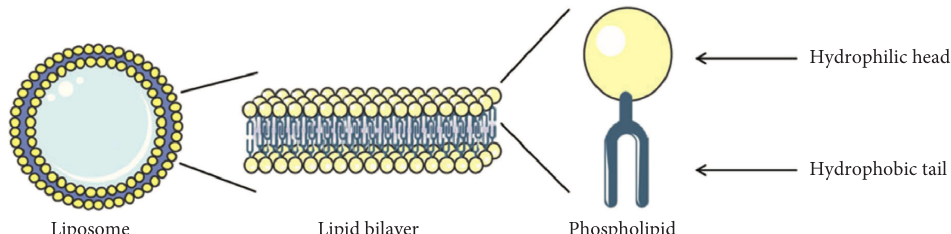
Figure 1: Diagram of a liposome including the amphiphilic phospholipid component that forms its concentric lipid bilayers